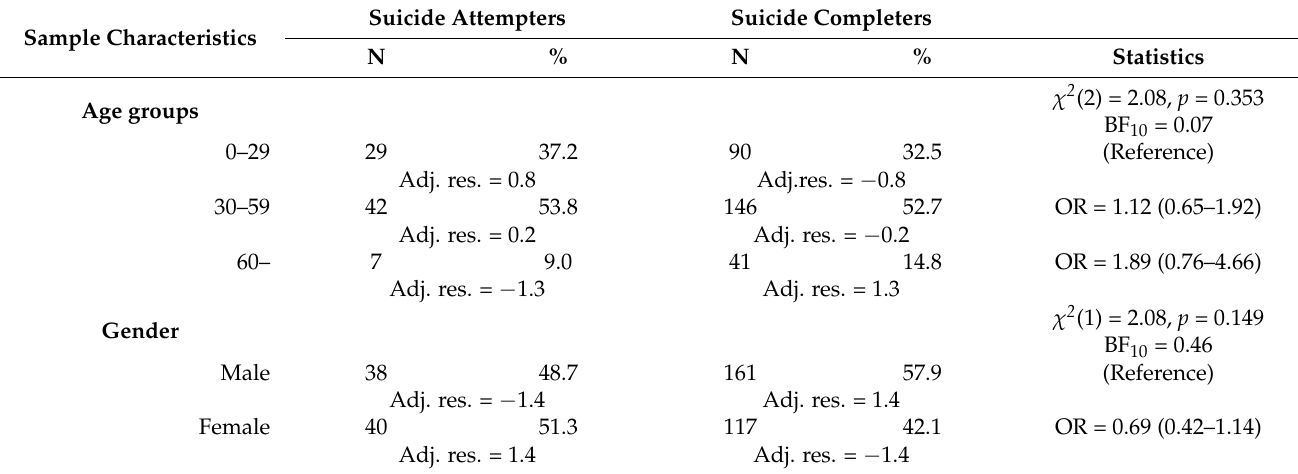
Table 1. Sociodemographic factors of suicide attempters (SA) and suicide completers (SC). Sample